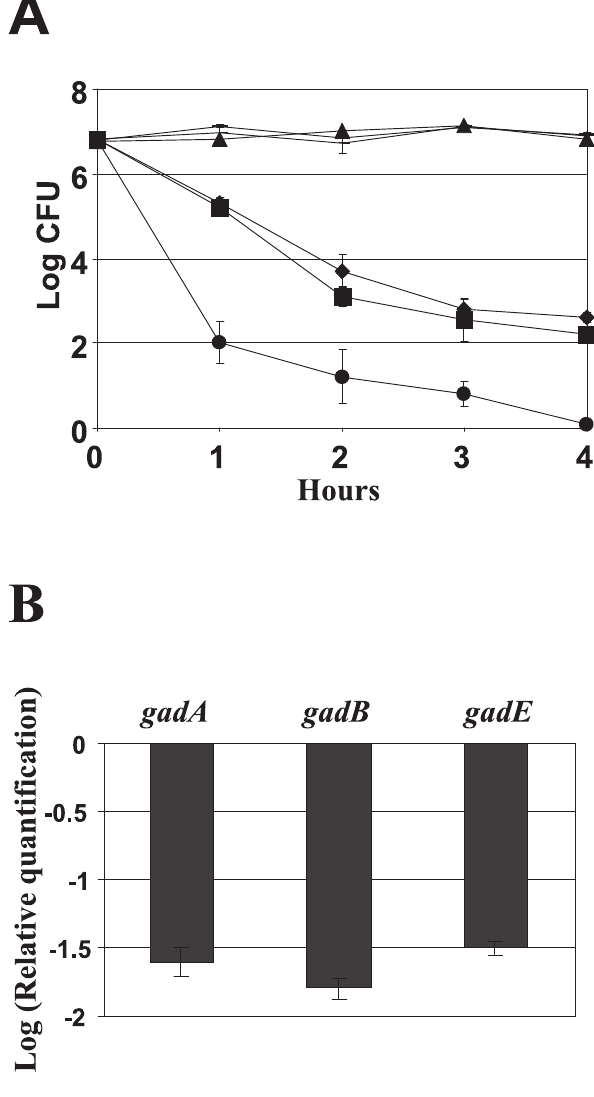
Figure 7. Over-expression of ybjN confers acid susceptibility. A. Effect of ybjN on acid susceptibility. Cells were grown for 18 h in M9 medium and bacterial suspensions were incubated in EG medium at pH 2.5 as described previously [44]. Surviving bacterial cells were counted at time 0, 1, 2, 3 and 4 h by dilution plating on LB plates. m : E. N coli strain BW25113 (BW), pH 7.0; _: ybjN , pH 7.0; -: BW (pYbjN1), pH 7.0; & : BW, pH 2.5, ¤ : ybjN , pH 2.5, : BW (pYbjN1), pH 2.5. B. Relative expression of acid resistance genes in ybjN over-expression strain. Bacterial strains were grown overnight in LB broth and re-inoculated in 5 mL M9 medium. Cells were grown in M9 medium for 8 h with shaking to an OD 600 of 0.5–0.8. Relative expression of gadA , gadB and gadE genes in ybjN over-expression strain compared to BW strain was determined by qRT- PCR, normalized to the expression value of 16S rRNA ( rrsA )